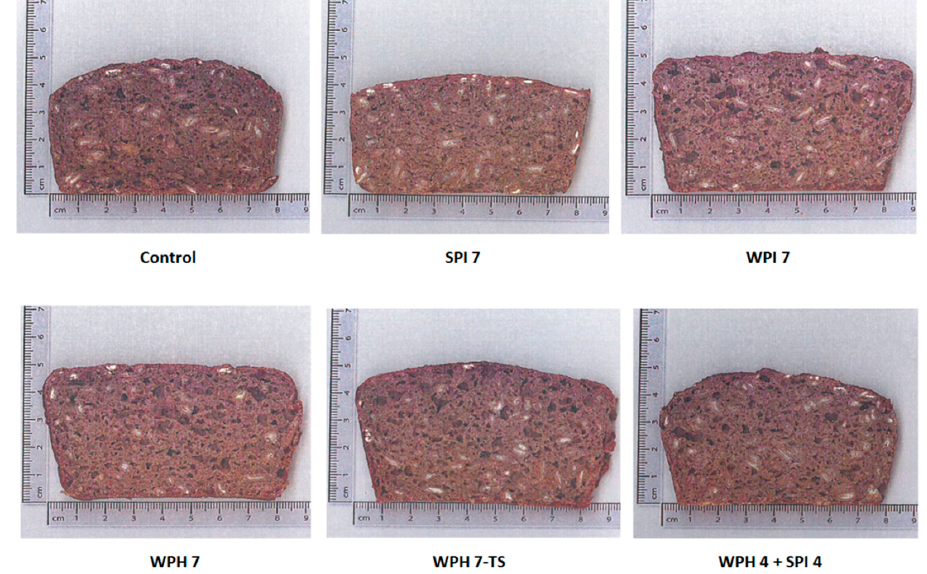
Figure 1. Example photos of cross section of rye bread samples. Labels: numbers indicate the amount of added protein (4 = 4%, and 7 = 7%); TS = texture and taste modified sample; WPH = whey protein hydrolysate; WPI = whey protein isolate; SPI = soy protein